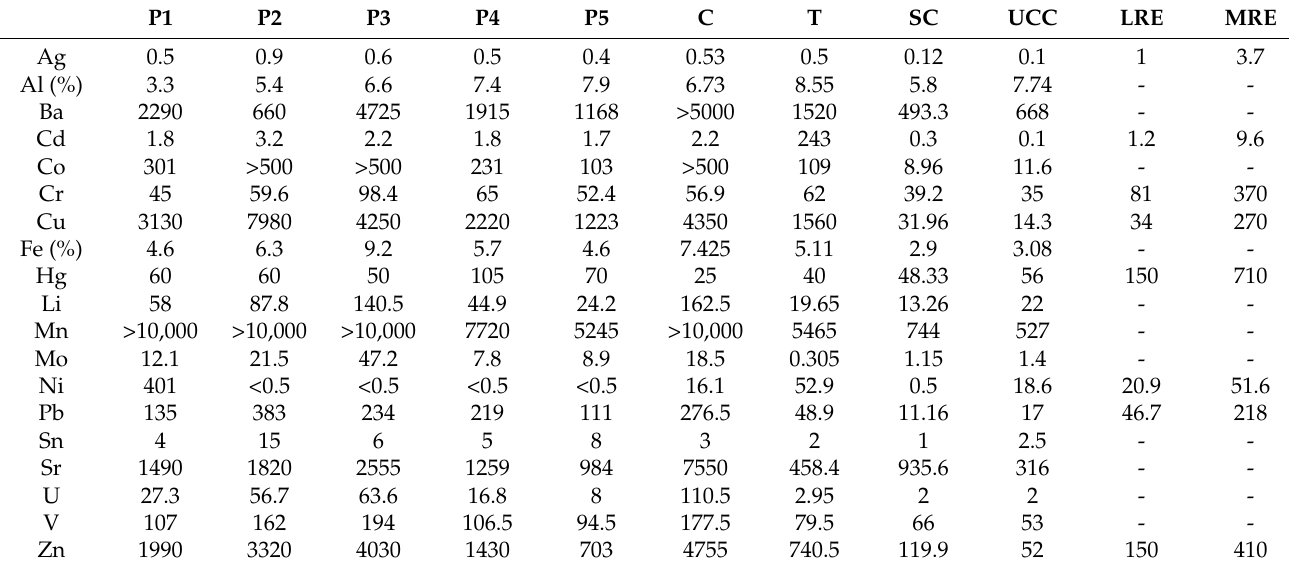
Table 3. Metal concentrations in sediments for the sampling stations in Santa Rosalia-Baja California Sur, control site, and contamination references. P = port, C = Cuevas, T = tanques, CS = control site, UCC = Upper earth cortex value, LRE = Low range effect, MRE = Medium range effect (mg kg − 1